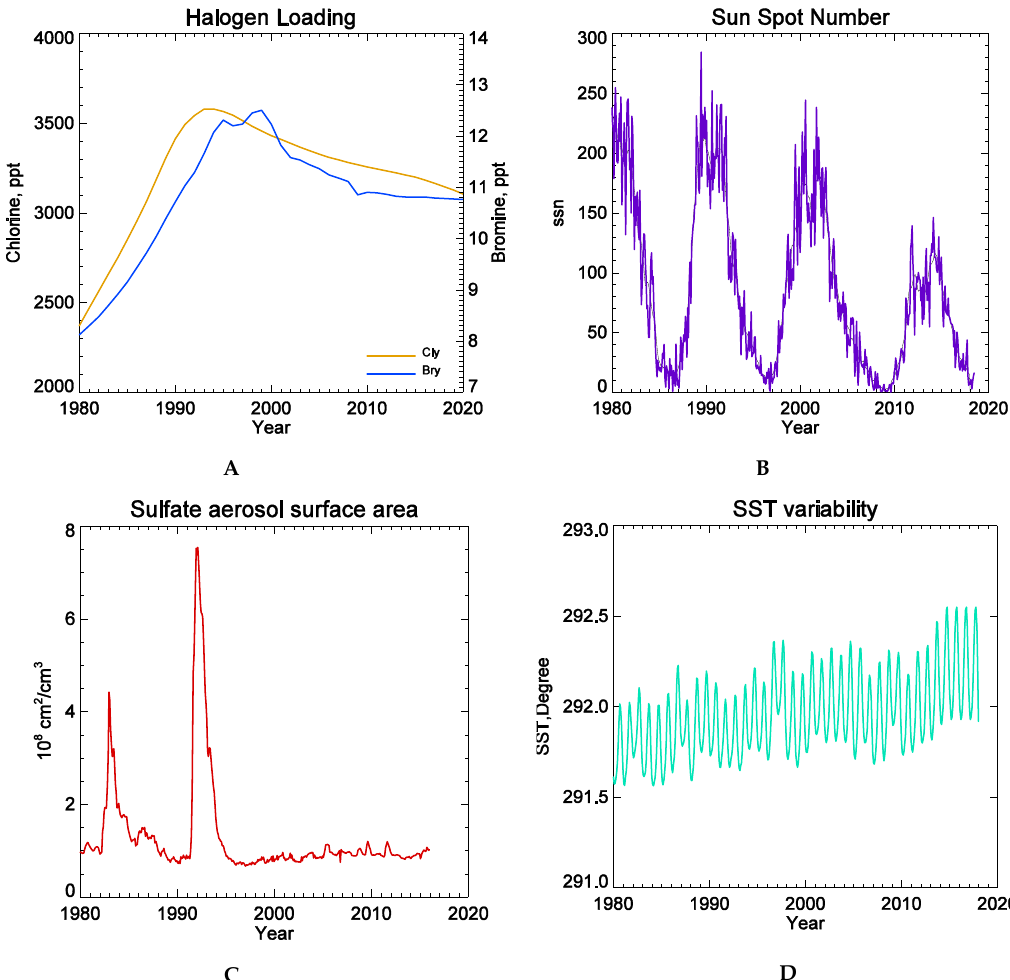
Figure 1. Interannual variability of the tested factors influencing ozone trends: ( A ) chlorine and bromine ozone destroyers; ( B ) sunspot number (SSN) variability [41]; ( C ) stratospheric aerosol; ( D ) sea surface temperature.